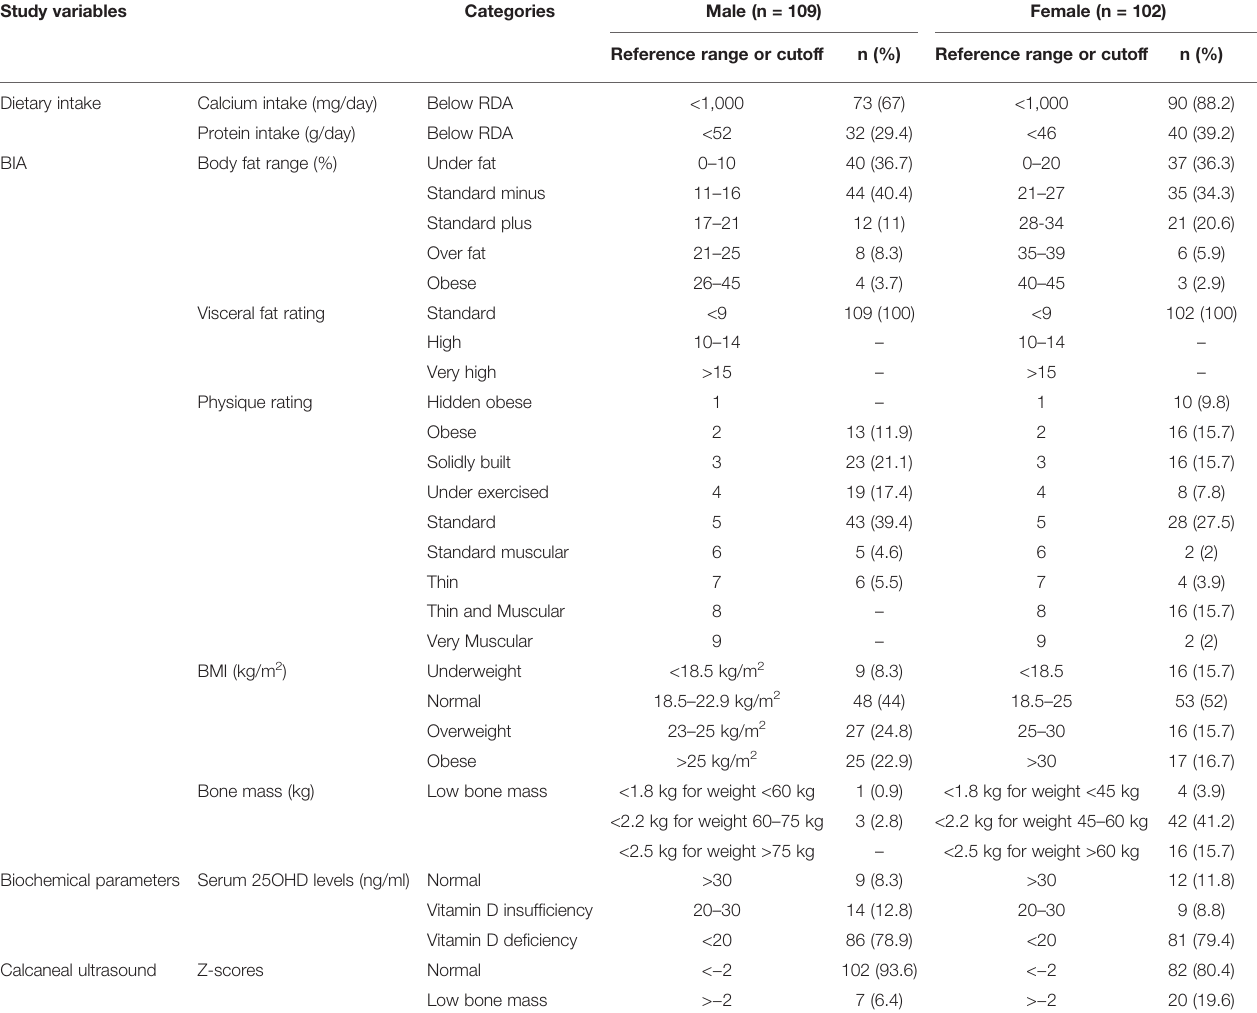
TABLE 2 | Descriptive categorization of subjects according to dietary intake, bioelectrical impedance analysis (BIA), biochemical and calcaneal ultrasound fi ndings.